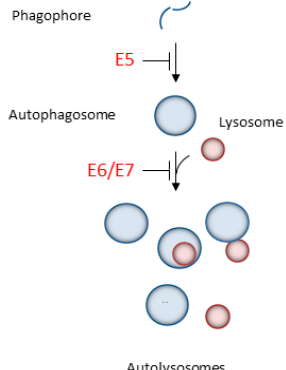
Figure 2. HPV16 oncoproteins dampen the host autophagic response acting at different levels of the autophagic pathway. E5 interferes with the transcriptional activation of the autophagic machinery down-regulating Beclin 1 , ATG5 , LC3 , ULK1 , ULK2 , ATG4a , and ATG7 mRNAs, thus suggesting inhibition of phagophore assembly, while E6 and E7 inhibit autophagosome/lysosome fusion may be due to depletion of autophagic genes. Arrows indicate activating pathways; T-bars indicate inhibitory pathways.